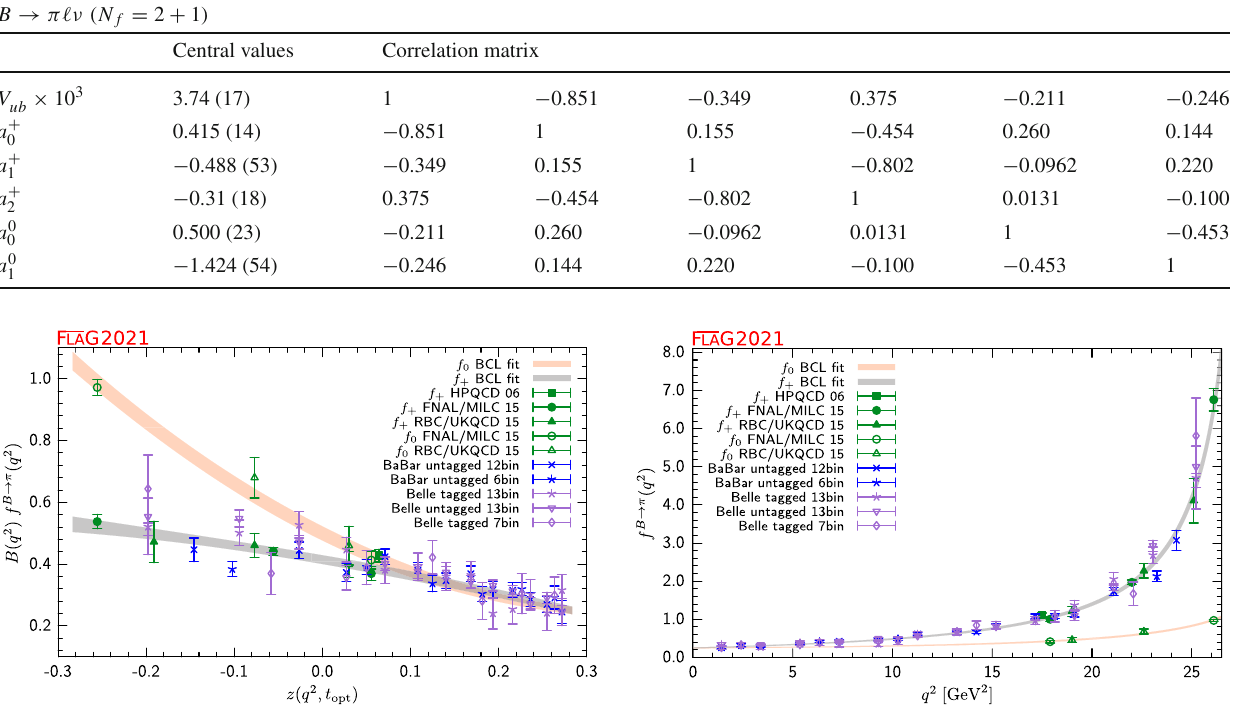
( q 2 ) versus z (left panel) and q 2 (right panel). Experimental data has been rescaled Fig. 35 Lattice and experimental data for f B → π + ( q 2 ) and f B → π 0 by the value for | V ub | found from the joint fit. Green symbols denote lattice-QCD points included in the fit, while blue and indigo points show experimental data divided by the value of | V ub | obtained from the fit. The grey and orange bands display the preferred N + = N 0 = 3 BCL fit (five z -parameters and | V ub |